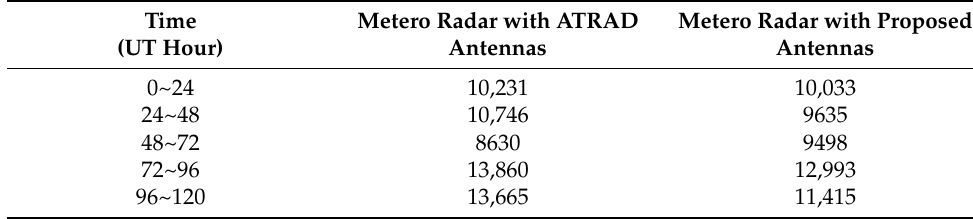
Table 3. Statics table of meteor quantity. Time (UT Hour)